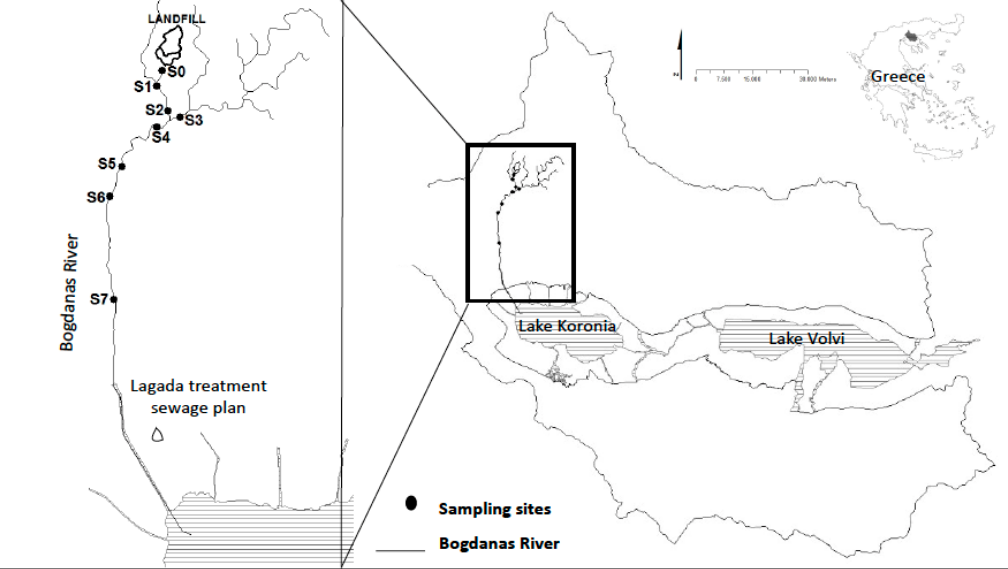
Figure 1. Bogdanas River (Mygdonia basin). Mavrorachis Landfill and sampling sites (S0-S7) are indicated .